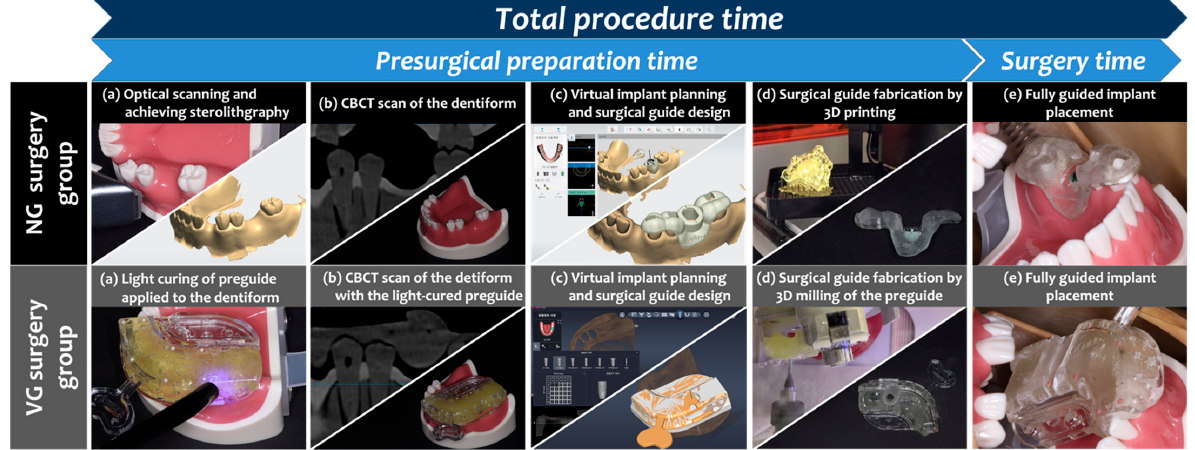
Figure 2. Complete workflows of the treatment procedures in the NG and VG